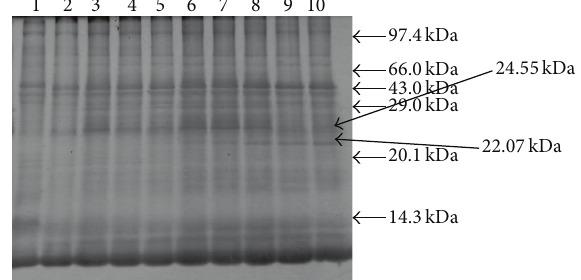
Figure 2: Protein profiles of fresh and liquefied semen. Lane 1, 0 hours; lane 2, 6 h; lane 3, 12 h; lane 4, 18 h; lane 5, 24 h; lane 6, 30 h; lane 7, 36 h; lane 8, 42h; lane 9, 48 h; and lane 10, 72 h.